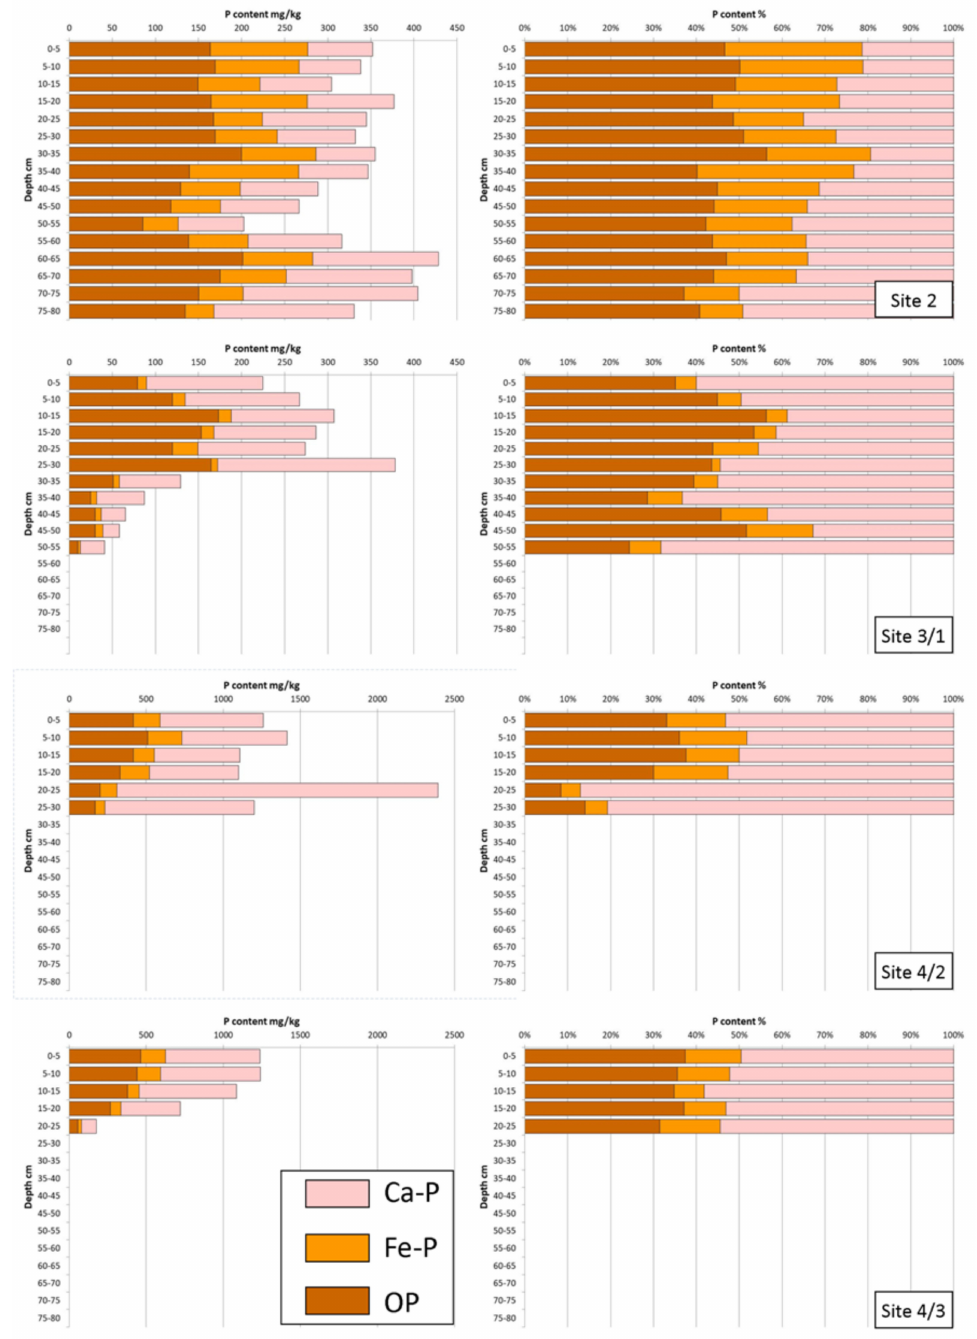
Figure 4. Concentration and contribution percentage of OP, Fe-P, and Ca-P in core sediment samples. Concerning the PCA, the value of 1227 × 10 4 for the Bartlett chi-square statistic (1225 degrees of freedom and a minimum significance level of 0.000) applied for Bartlett’s sphericity test indicates the existence of a good correlation between the variables. Moreover, the measure of sampling adequacy (MSA) obtained by the Kayser–Meyer–Olkin (KMO) measure returns a rather high value (0.875), validating the PCA application. To reduce the overlap of the original variables over each factor,